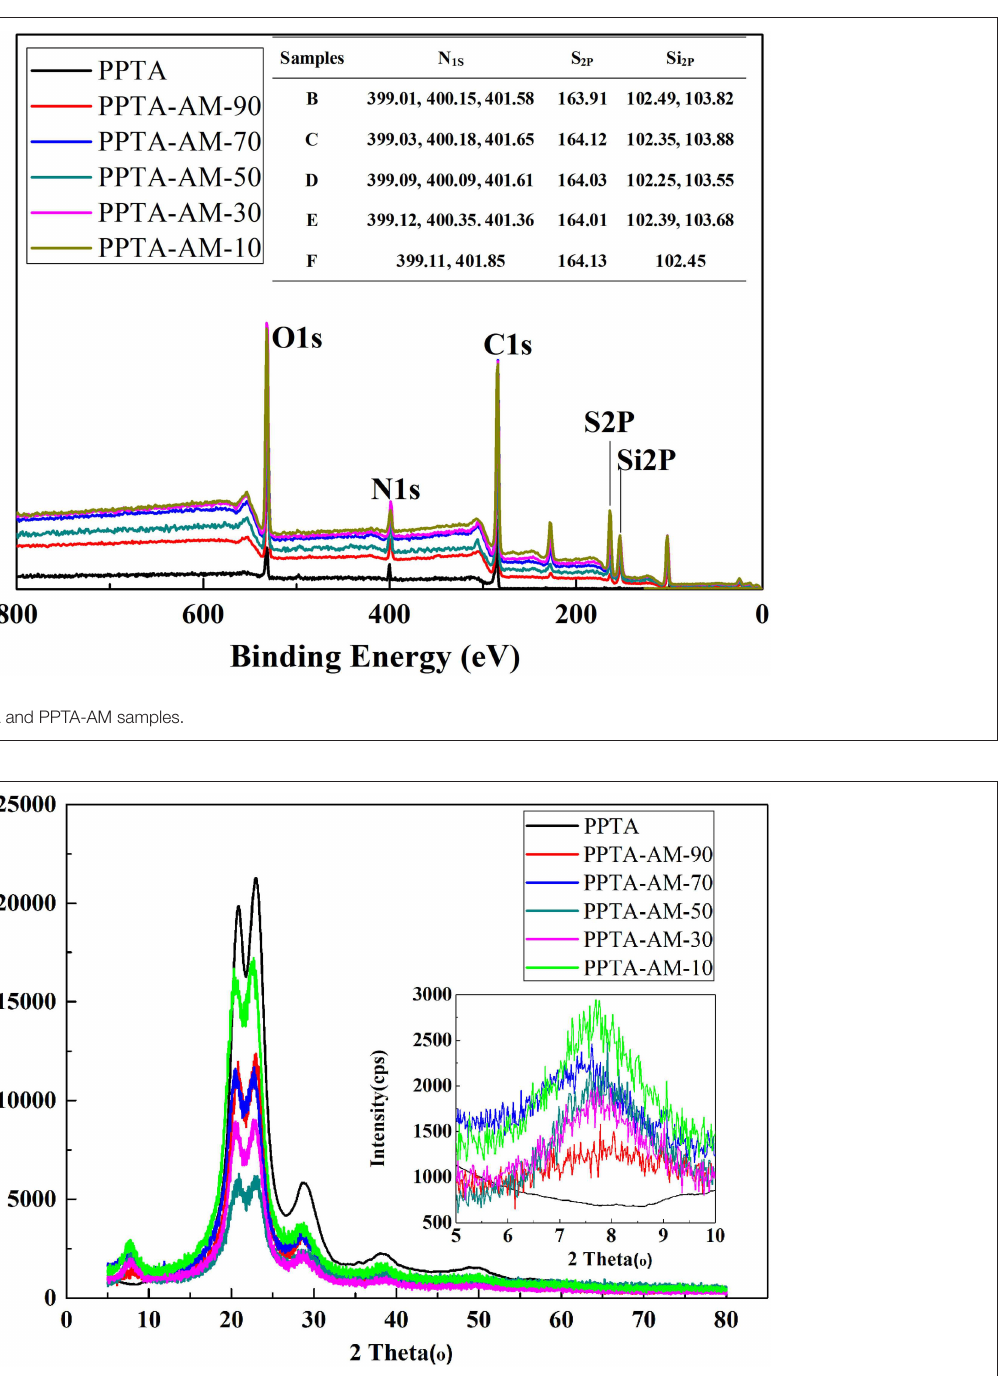
FIGURE 4 | XRD patterns of PPTA and PPTA-AM